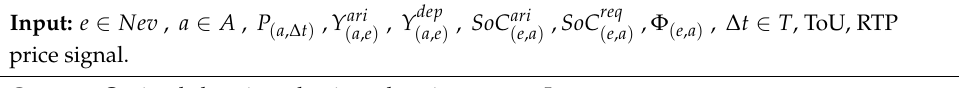
Algorithm 2: Power Allocation to EV Aggregator